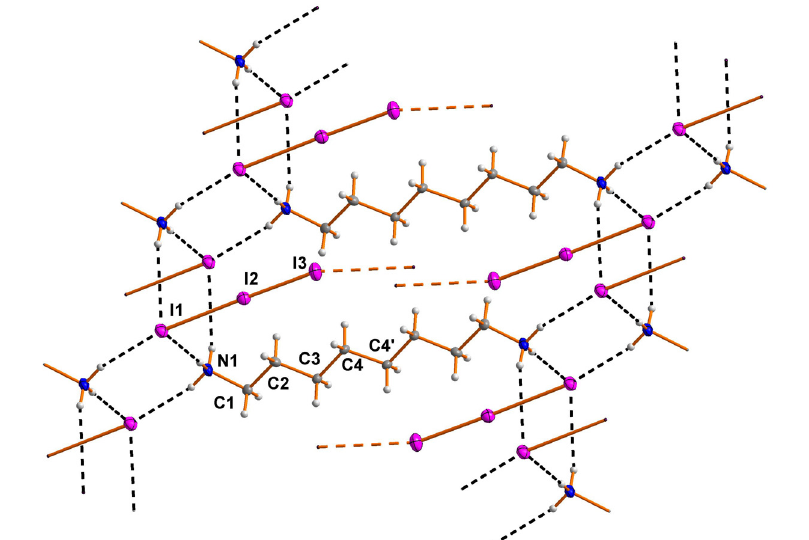
Figure 2. The staircase-shaped hydrogen bonded motif in 18dbt . Each staircase-shaped unit (shadowed) is constructed by two cyclic elements with the graph-set descriptor R 2 The polyiodides and the alkan-diyl units connect these hydrogen-bonded strands to a three-dimensional framework (symmetry code: ' = 2 − x , − y , 2 − z